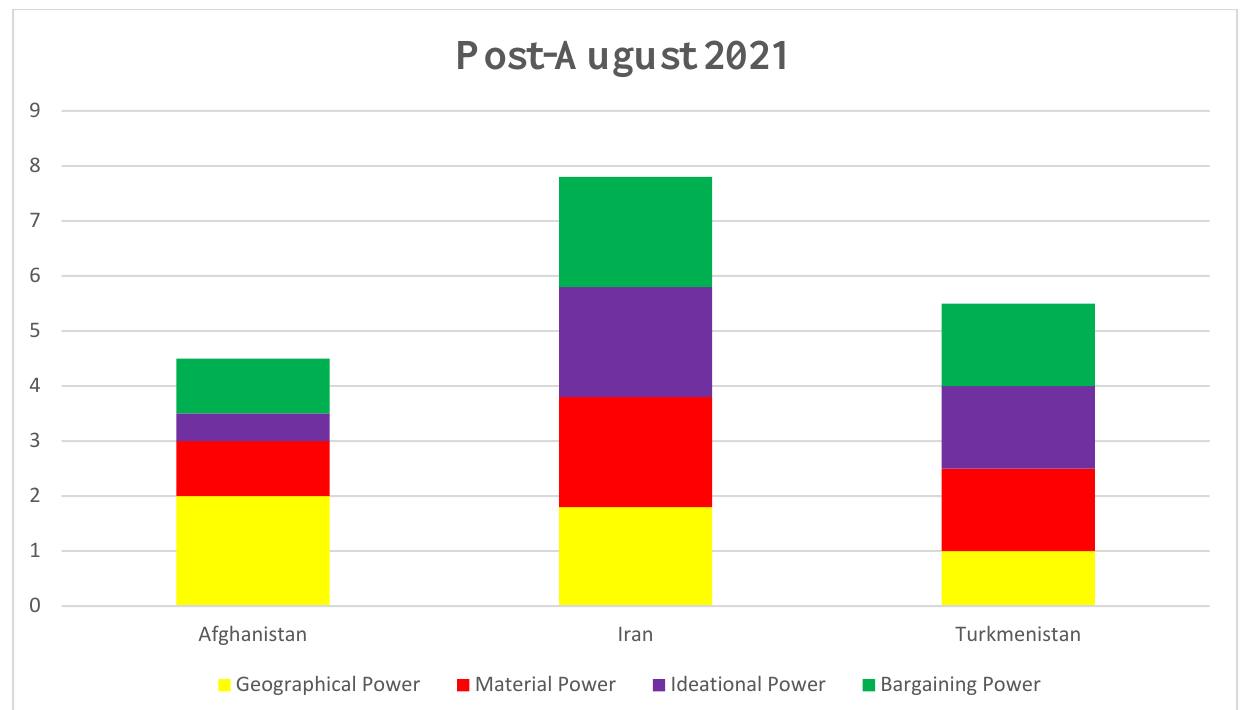
Figure 2. The illustration of power dynamic in four pillars of the Hydro-hegemony Framework in the Harirud River Basin before August 2021.